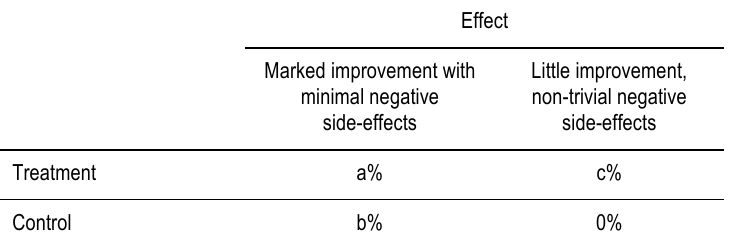
Table 5. Suggested statistical analysis of innovations